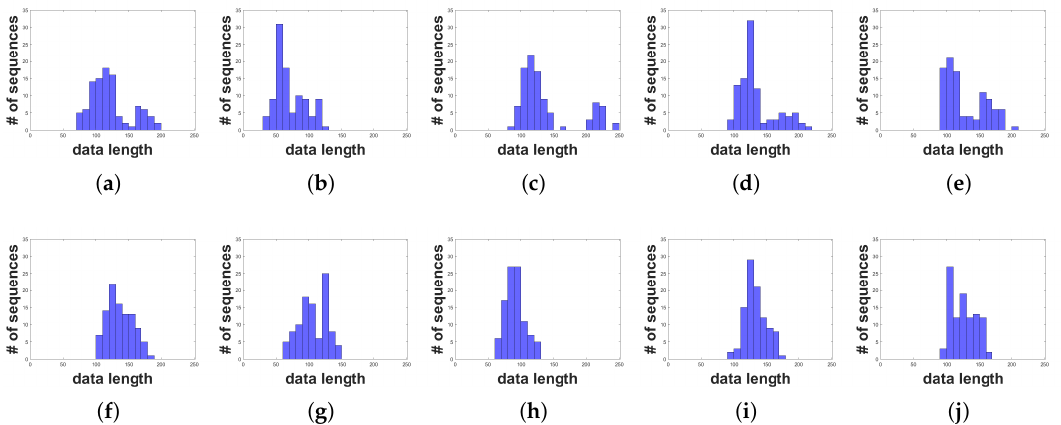
Figure 8. Histogram of the dataset: ( a ) label 0; ( b ) label 1; ( c ) label 2; ( d ) label 3; ( e ) label 4; ( f ) label 5; ( g ) label 6; ( h ) label 7; ( i ) label 8; ( j ) label 9.